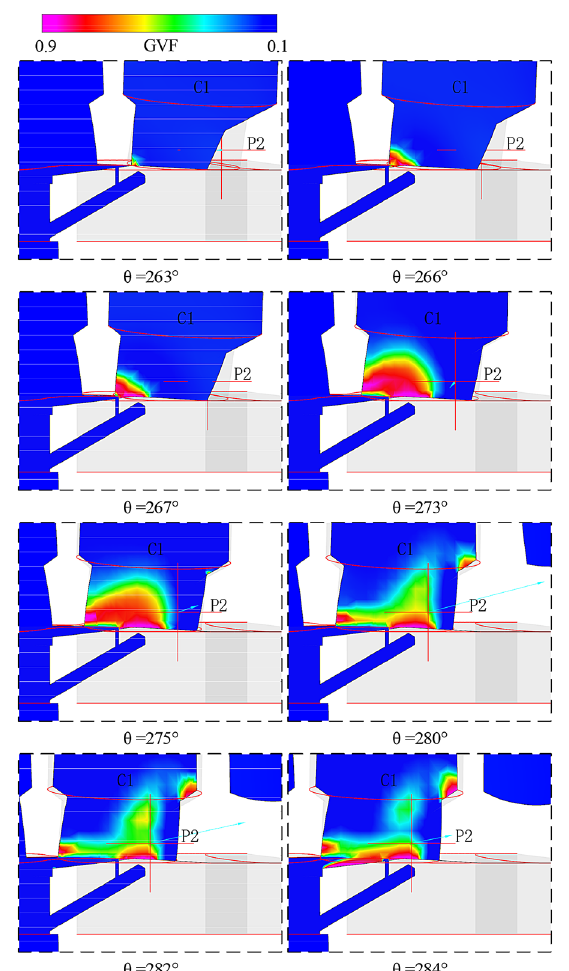
Figure 13 Changes of cross section II velocity cloud map and velocity vector at point P2 Figure 14 Gas volume fractional cloud on cross section